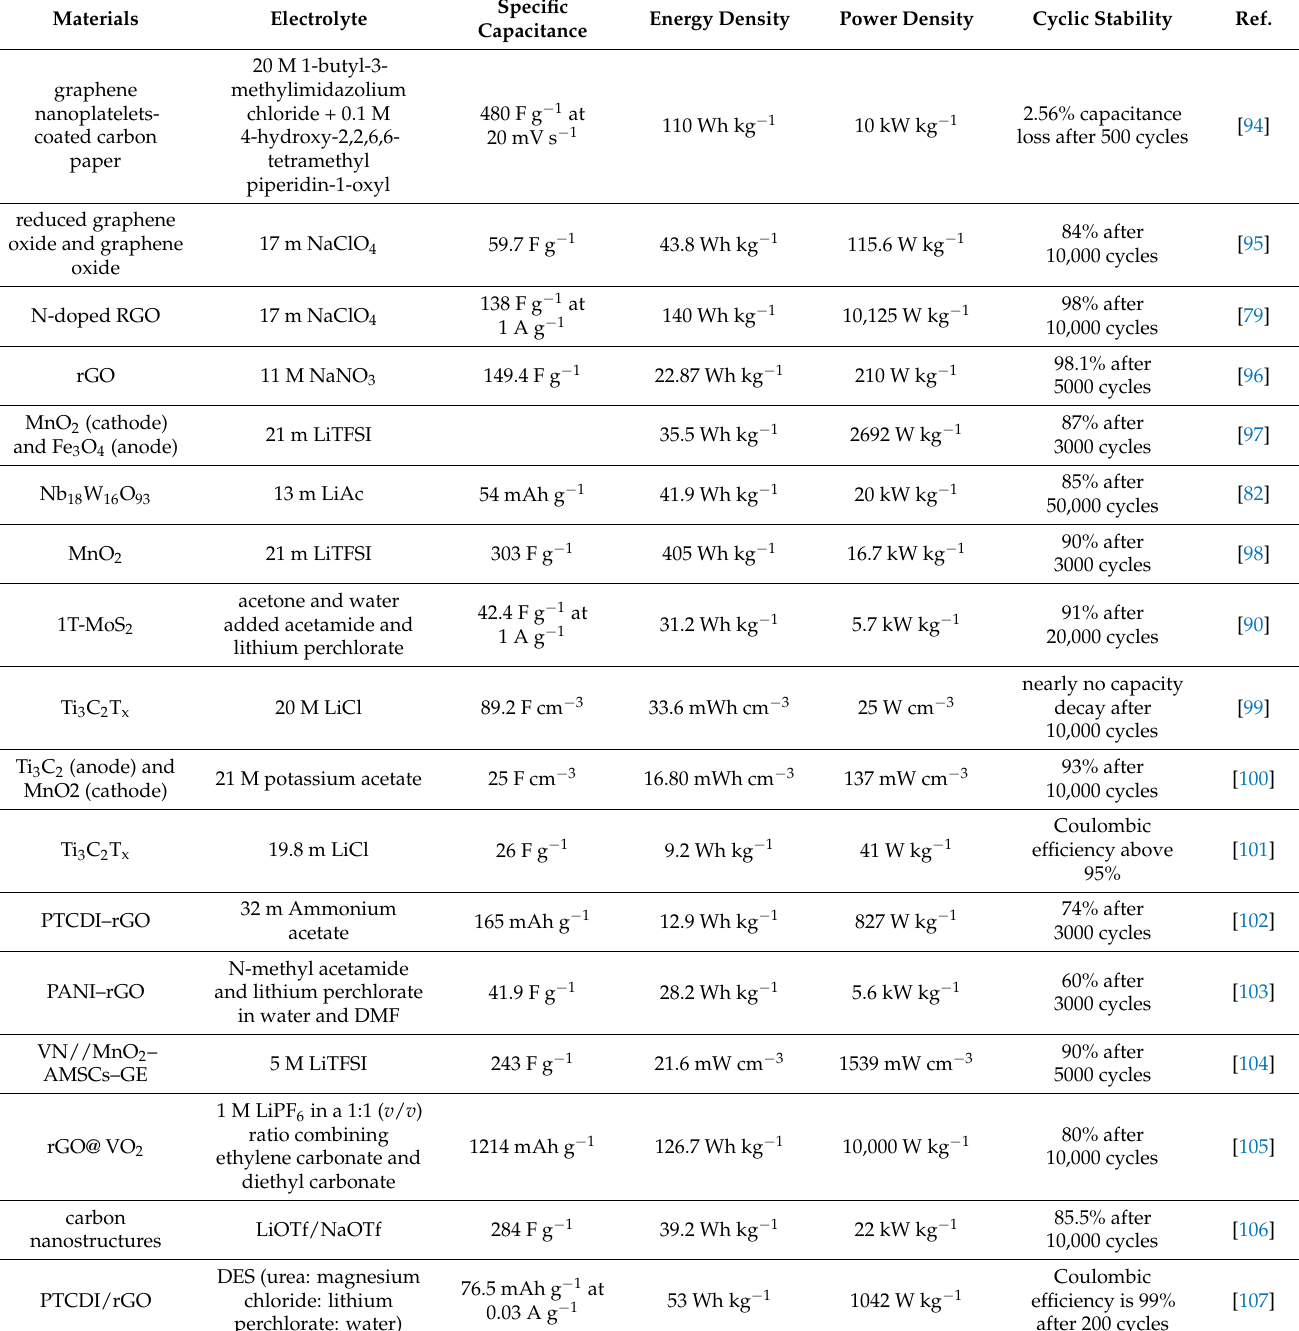
Table 1. A summary of the performance of 2D electrode materials in nonconventional